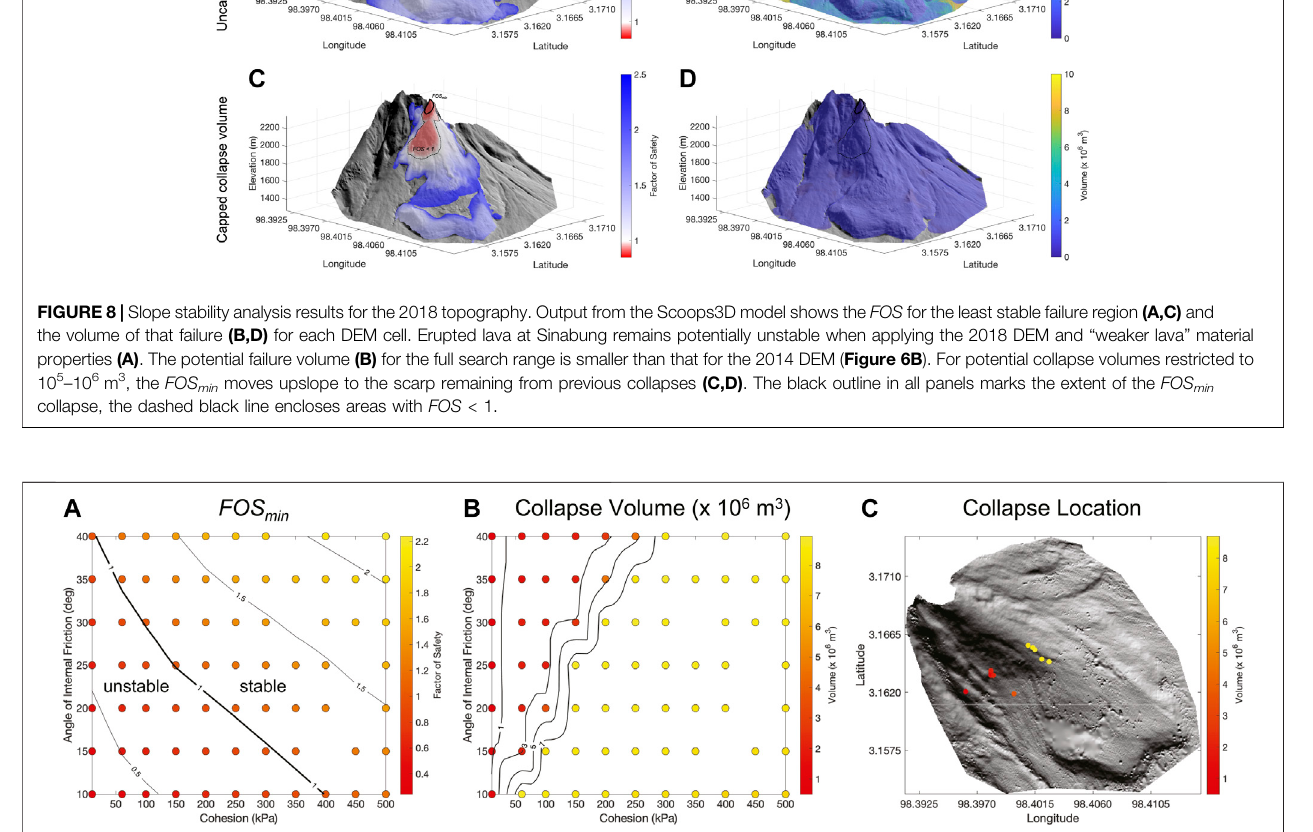
Frontiers in Earth Science |